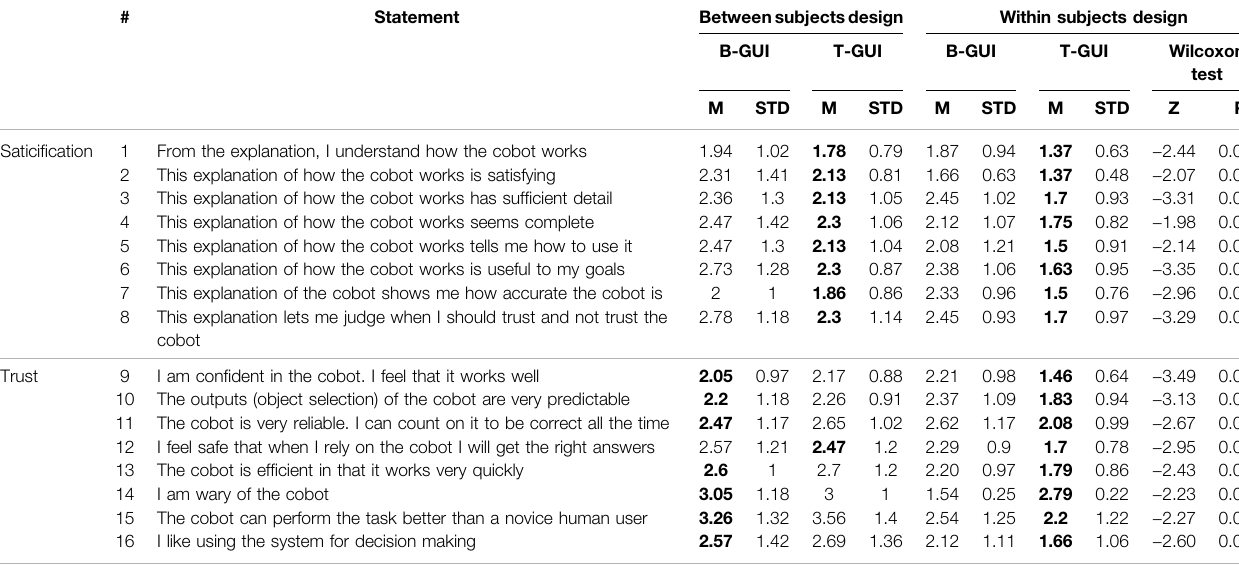
TABLE2| Illustrationoftheappliedstatementswhichareselectedfrom(Hoffmanetal.,2018)andthecomparisonoftheobtainedmeanandstandarddeviationineachitem for the proposed and baseline models for the two used experimental designs. Following, Hoffman et al. (2018), 1 indicates strongly agree and 5 indicates strongly disagree, therefore, the lower the rating, the better are the results, except for statement number 14, which is inverse